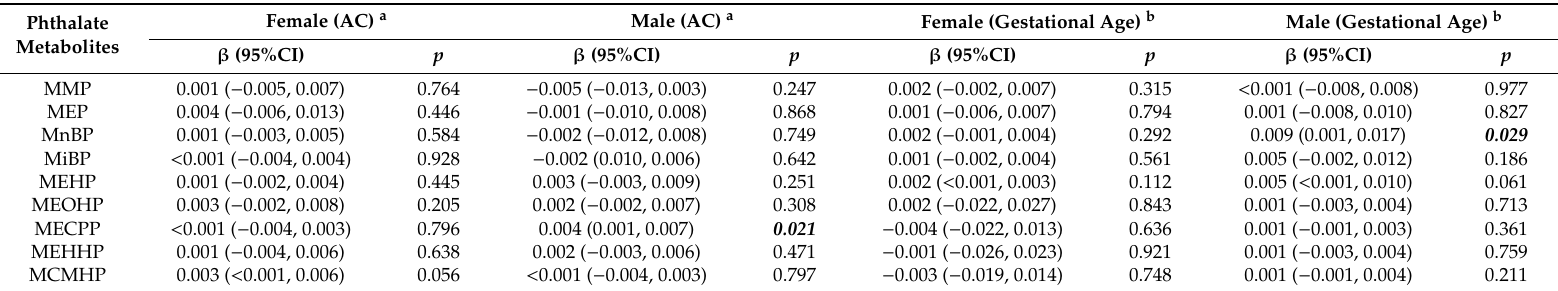
Table 5. Linear regression analysis of relationship between the phthalate metabolites and AC and gestational age in male and female